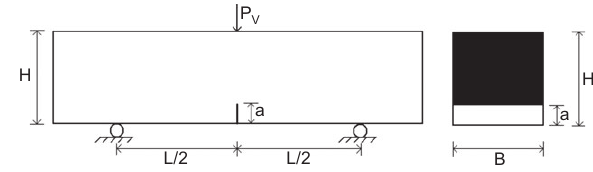
Figure 1 Sketch picture of the three-point bending beam